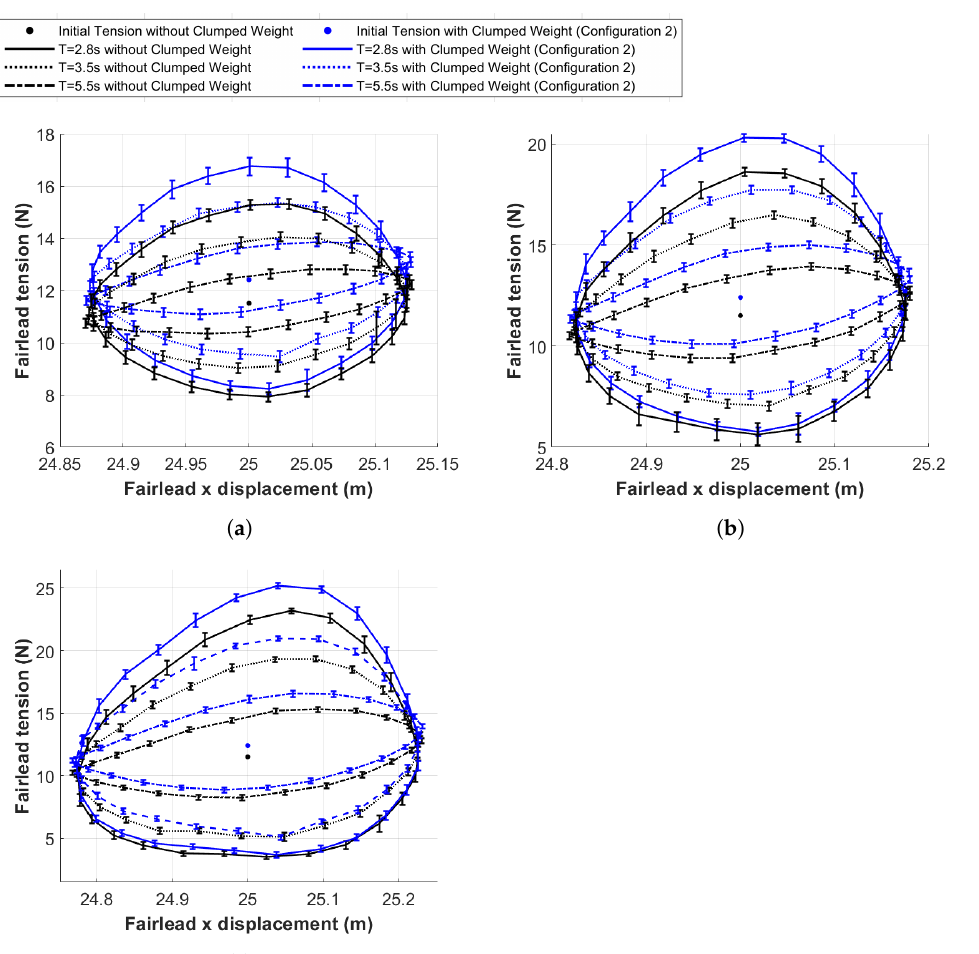
Figure 13. Fairlead tension during the fairlead displacement with and without clumped weight for three different fairlead amplitude values and Configuration 2. ( a ) A = 0.125 m. ( b ) A = 0.175 m. ( c ) A = 0.225